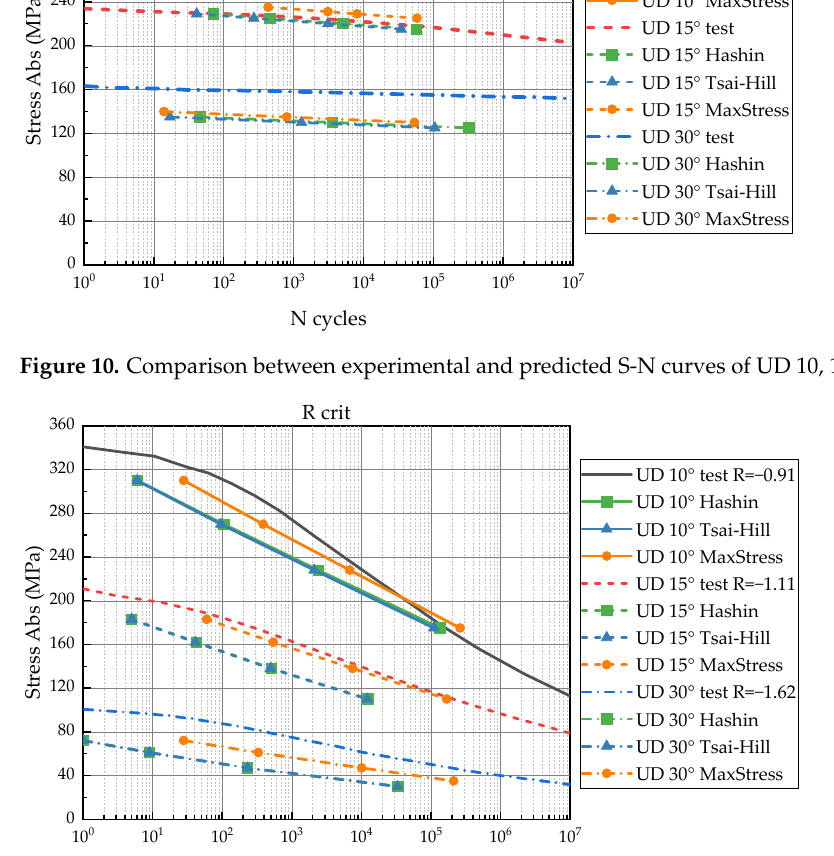
Figure 11. Comparison between experimental and predicted S-N curves of UD 10, 15, 30° for R crit (combined tension-compression mode).